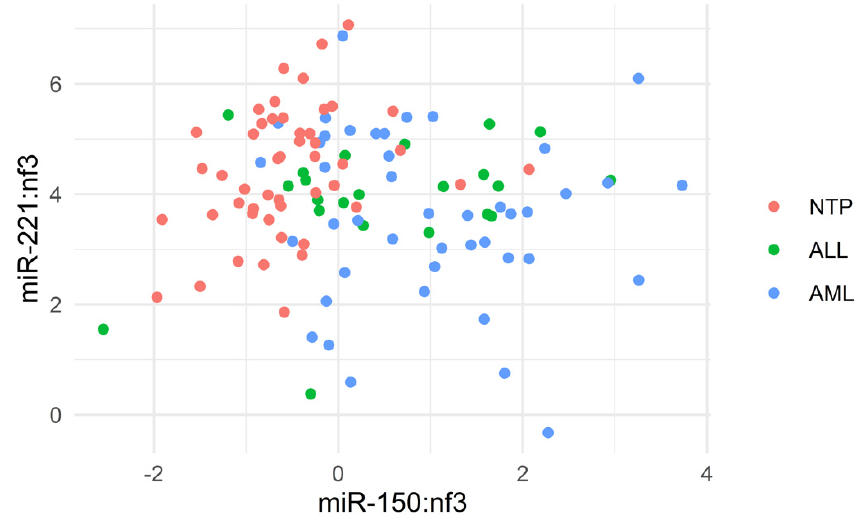
Figure 2. The scatterplot of miR-150:nf3 and miR-221:nf3 for individual patients.